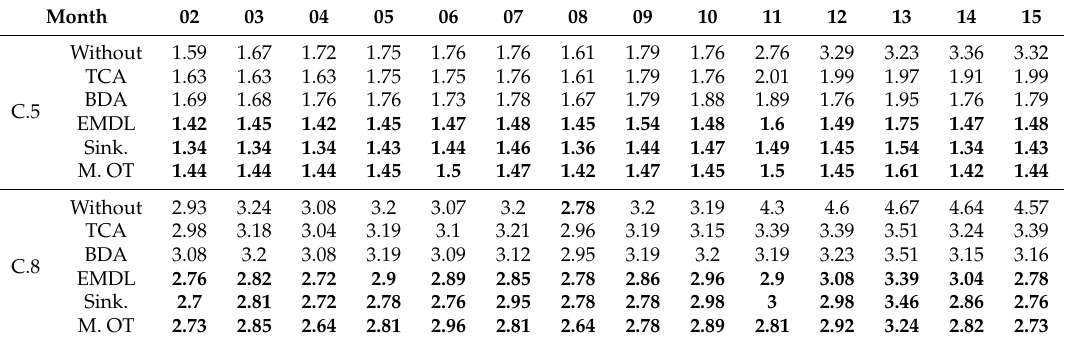
Figure 10. The performance of the transfer learning algorithms on the measured FL data set: ( a ) transductive setting and ( b ) out-of-sample setting. Table 2. The performance of the transfer learning algorithm on the measured FL data set (transductive setting).